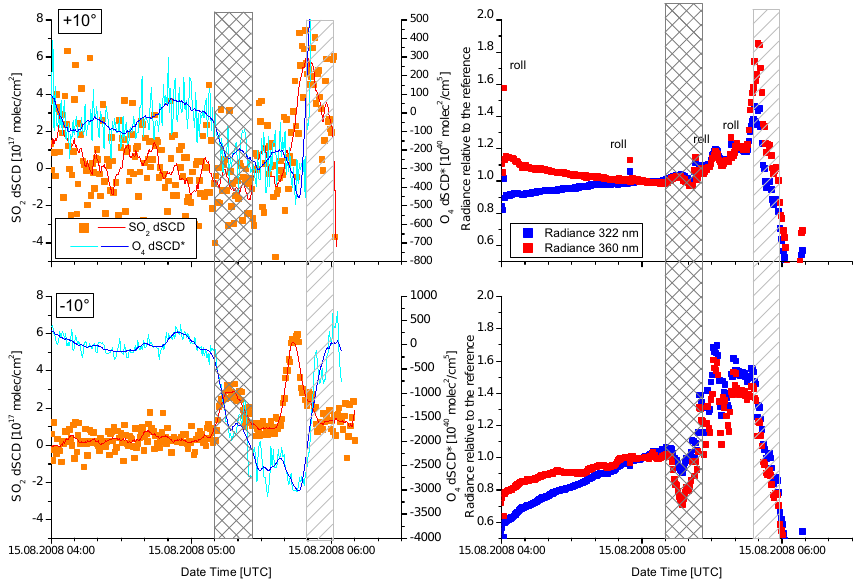
Fig. 4. left: Time series of SO 2 and O 4 dSCDs for the two viewing directions − 10 ◦ (bottom) and +10 ◦ (top). Due to the limited spectral range of the detector the +10 ◦ retrieval is very noisy and the detection limit is rather high, however, around 05:48 an enhanced dSCD is also observed. Right: Relative intensity for the wavelength 320nm and 360nm, normalised to the reference (05:00UTC). During the first SO 2 peak the intensity of the downward looking instrument is reduced by the cloud (cross hashed); the opposite effect is found for the upward telescope. The dive through the cloud is marked by the hashed area. Some intensity data points seem to be outliers, but can easily be explained by the roll angle of the plane, when the telescope is directed to the cloud.